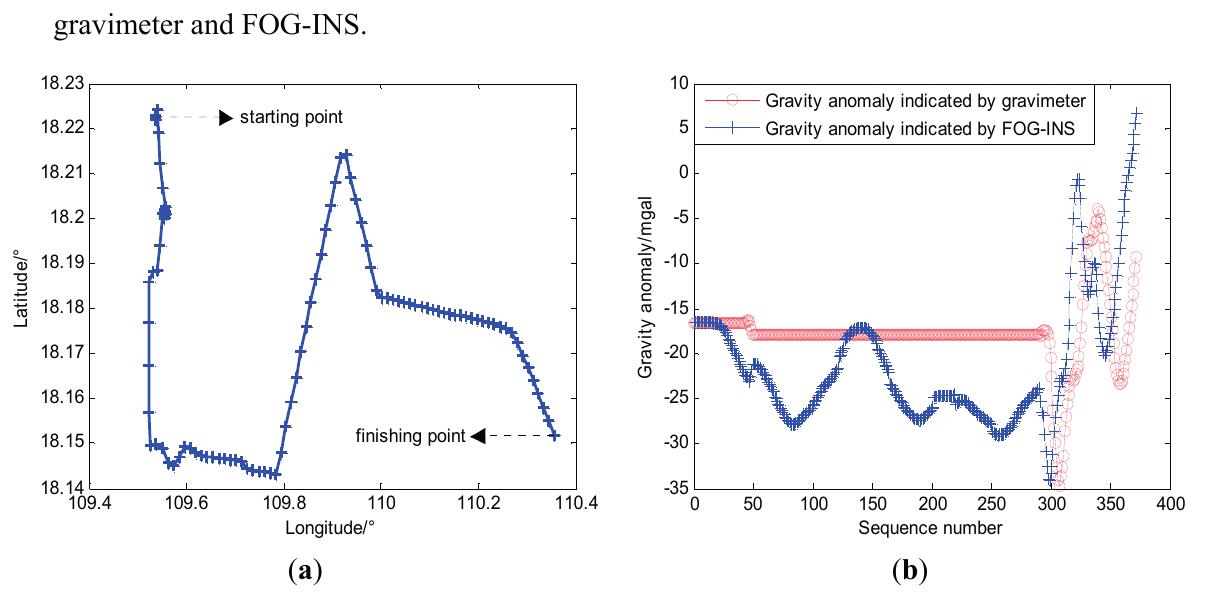
Figure 19. The results of gravity matching in ocean